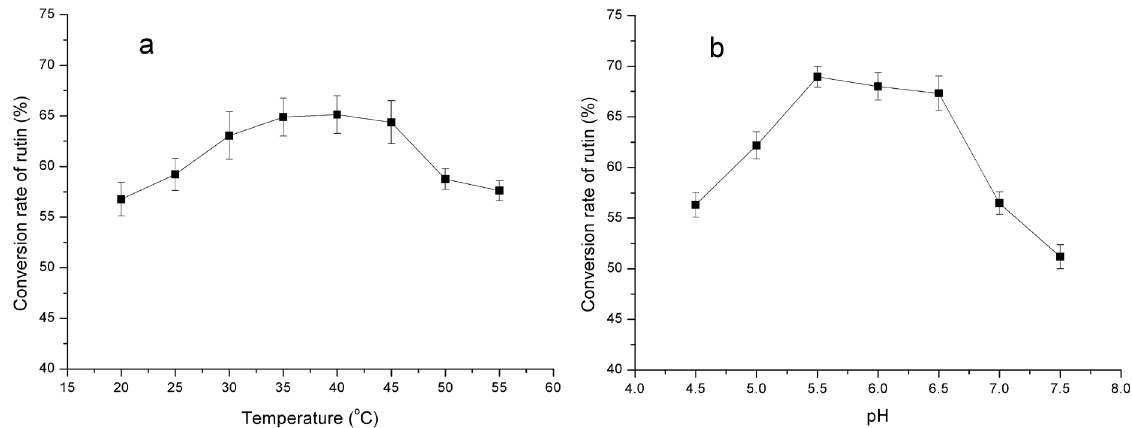
Figure 5. Effects of temperature ( a ) and pH ( b ) on rutin transglycosylation in the MAR